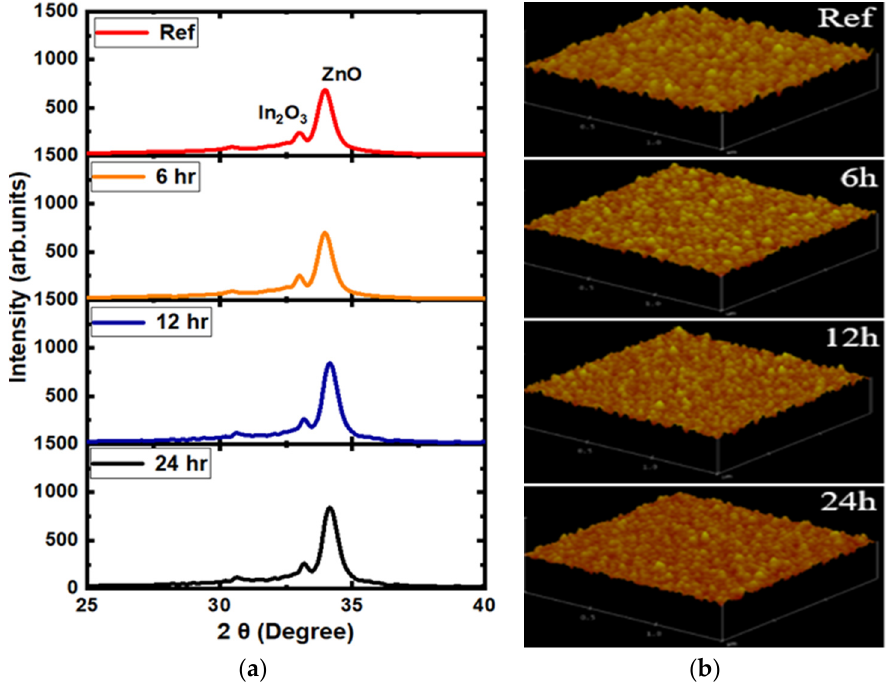
Figure 2. ( a ) X-ray diffraction pattern and ( b ) atomic force microscopy of the 5 mTorr reference and water-soaked samples, after water soaking for various durations.